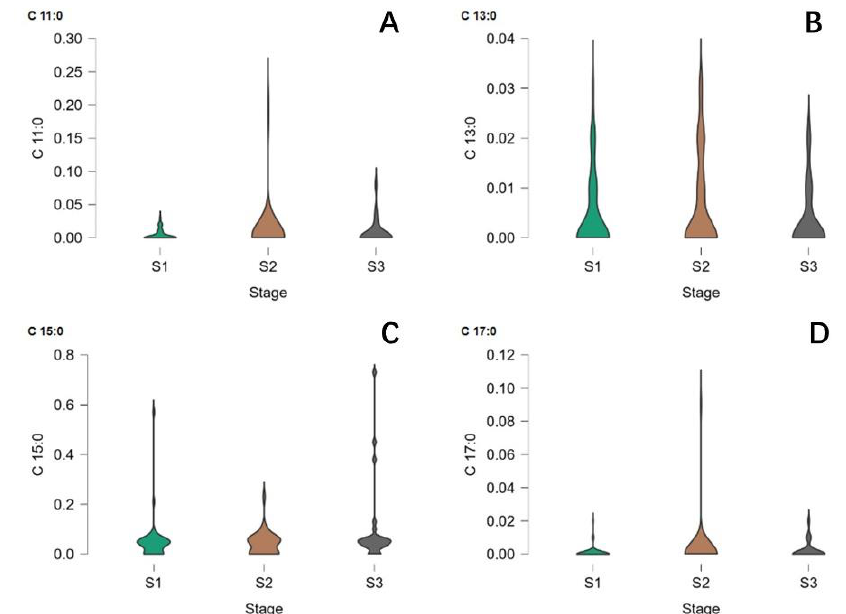
Figure 5. Comparison of OCFA contents in different infant formulas. Violin plot of A : C11:0, B